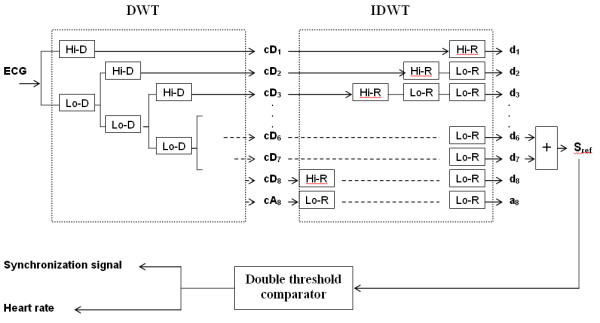
Overview of the extraction algorithm. The contaminated ECG is decomposed into 8 scales; the reference signal is then constructed by adding together the 6th and 7th sub-bands signals. A simple trigger generates the cardiac rhythm as well as the synchronization signal. Hi-D and Hi-R are respectively the high pass decomposition filter and its associated reconstruction filter. Lo-D and Lo-R represent the low pass decomposition and reconstruction filters. cDj denotes the detail coefficients, and dj are the reconstructed detail signals.